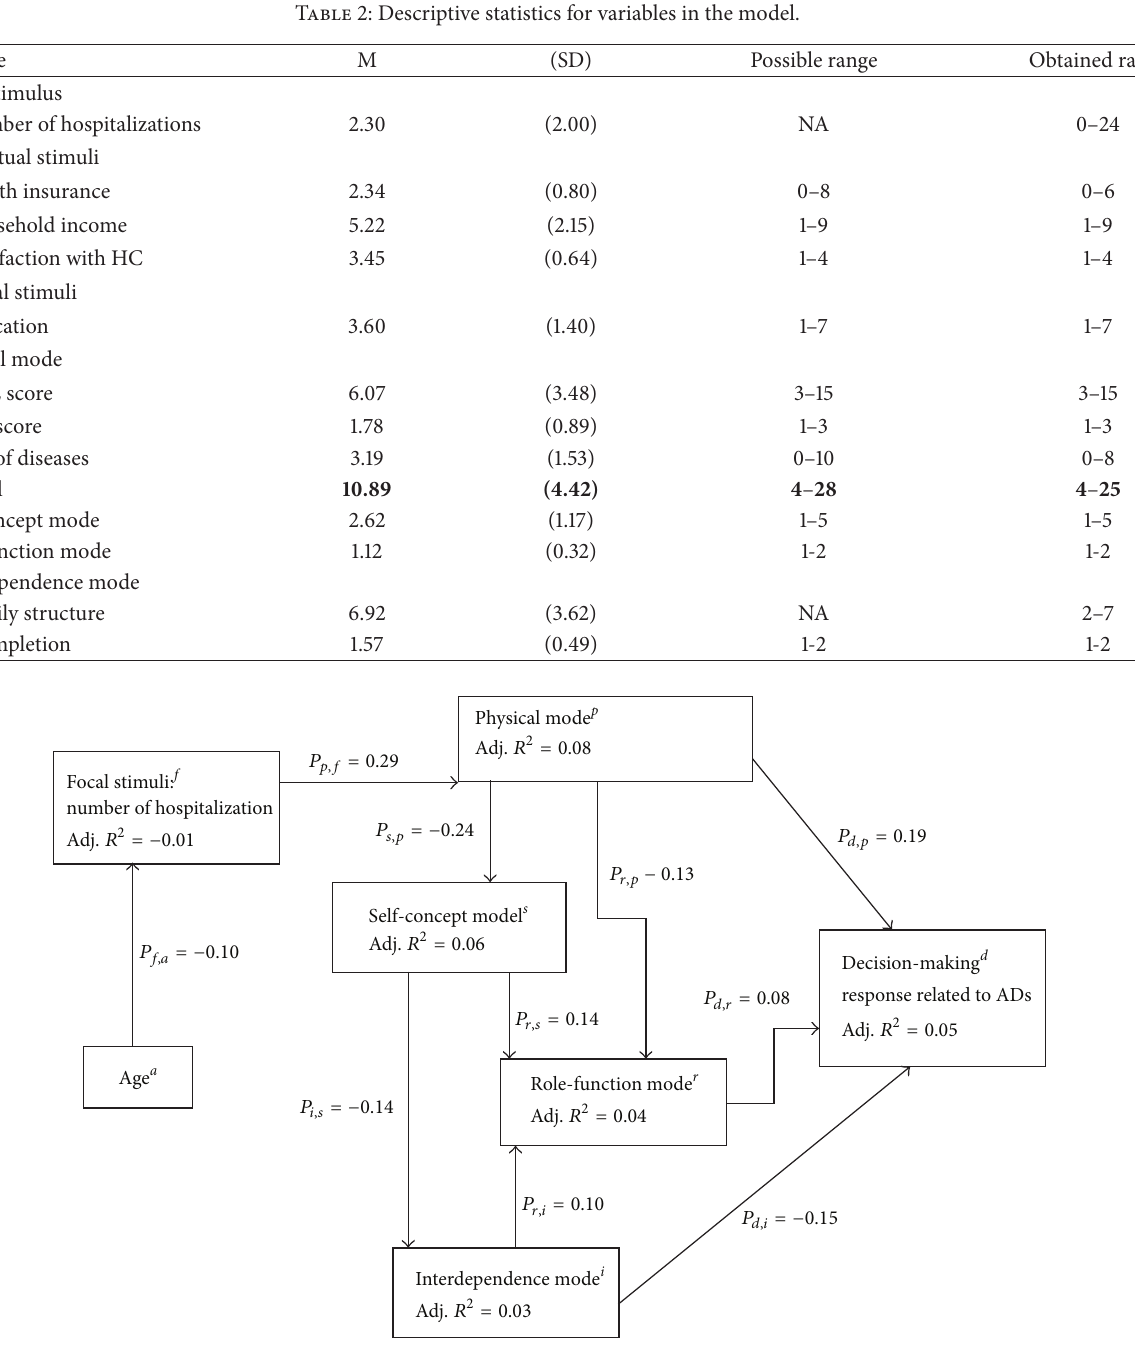
Figure 2: Final path model for AD